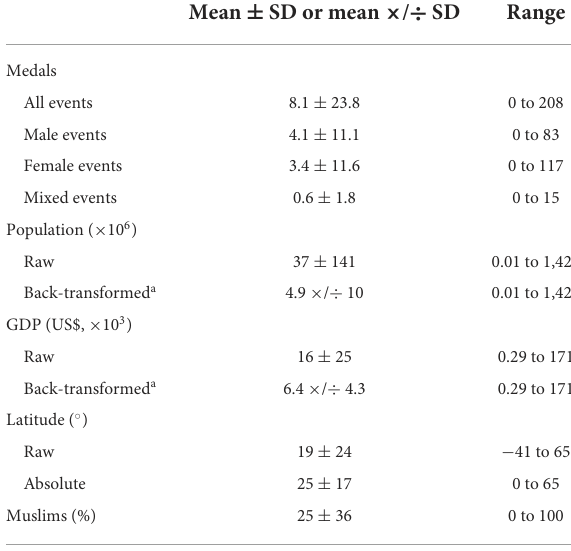
TABLE 6 Descriptive statistics of the 91 nations that attended the Pyeongchang winter Paralympics in 2018.